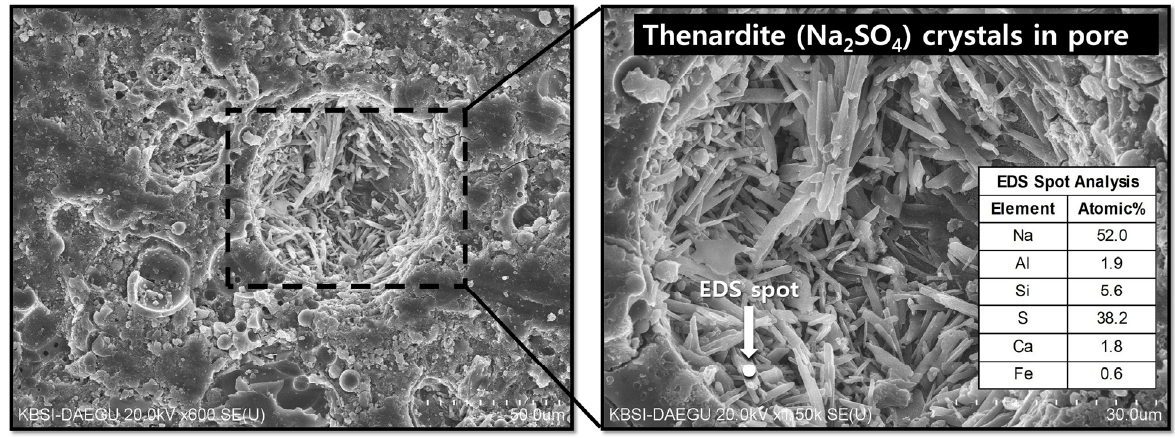
Figure 8. Crystals of thenardite (Na 2 SO 4 ) observed in a pore space of FG6-NW (sample with 6% gypsum) at 28